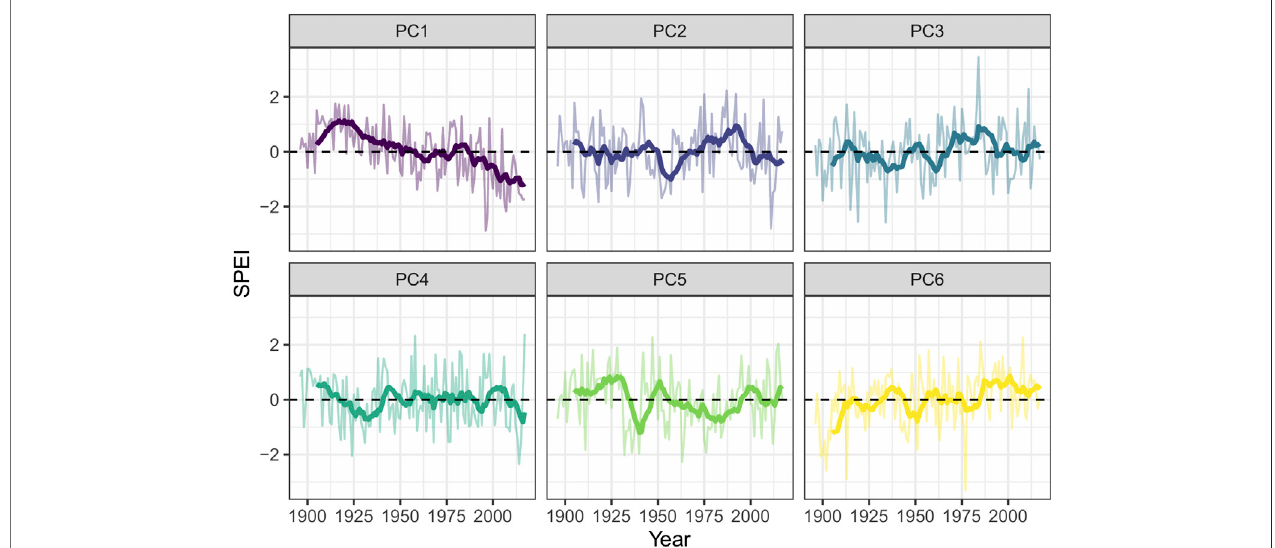
FIGURE 2 | Time series associated with the leading six PCs for the observational period, after varimax rotation. The y -axis corresponds to the 12-month StandardizedPrecipitation-EvapotranspirationIndex(SPEI),thenormalizeddeviationfromtheaverageclimaticwaterbalanceforagivenmonthon12-monthtimescale. SPEI values can be interpreted as z-scores in a normal distribution (i.e., a value of 1 is one standard deviation wetter than average for that location, − 1 is one standard deviation drier). 10-year moving averages superimposed over raw annual values.